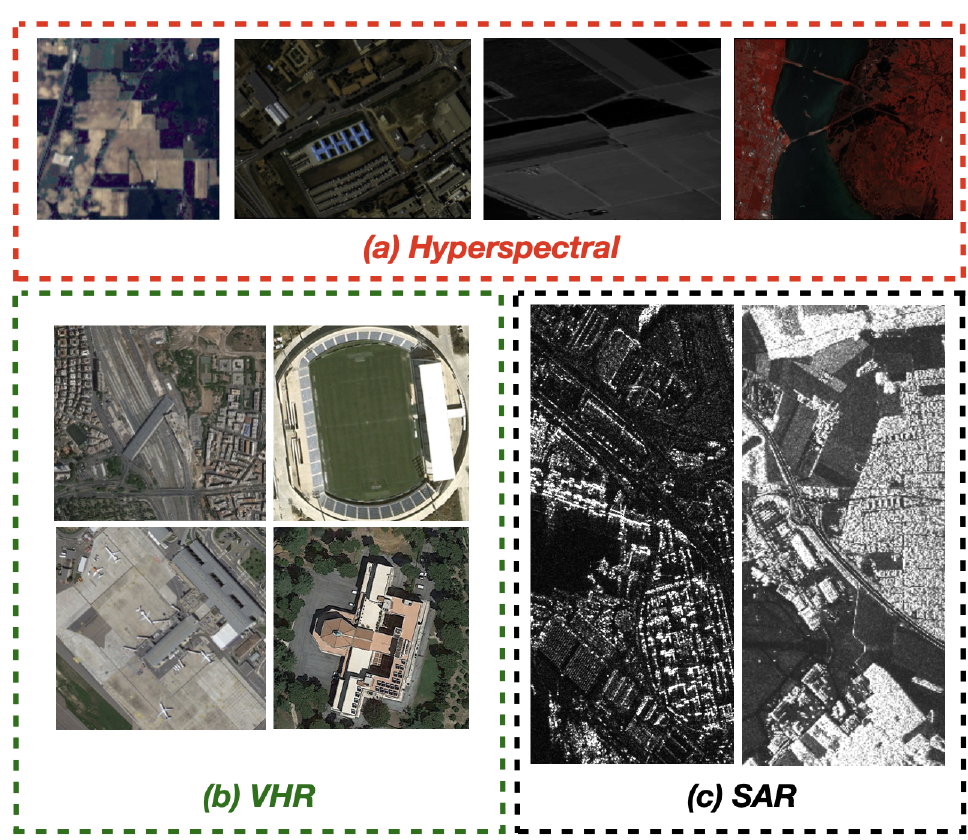
Figure 2. Example hyperspectral images from Pavia, Indian Pines and Kennedy Space Center datasets ( a ), example VHR images ( b ) and SAR images of the L band E-SAR dataset ( c